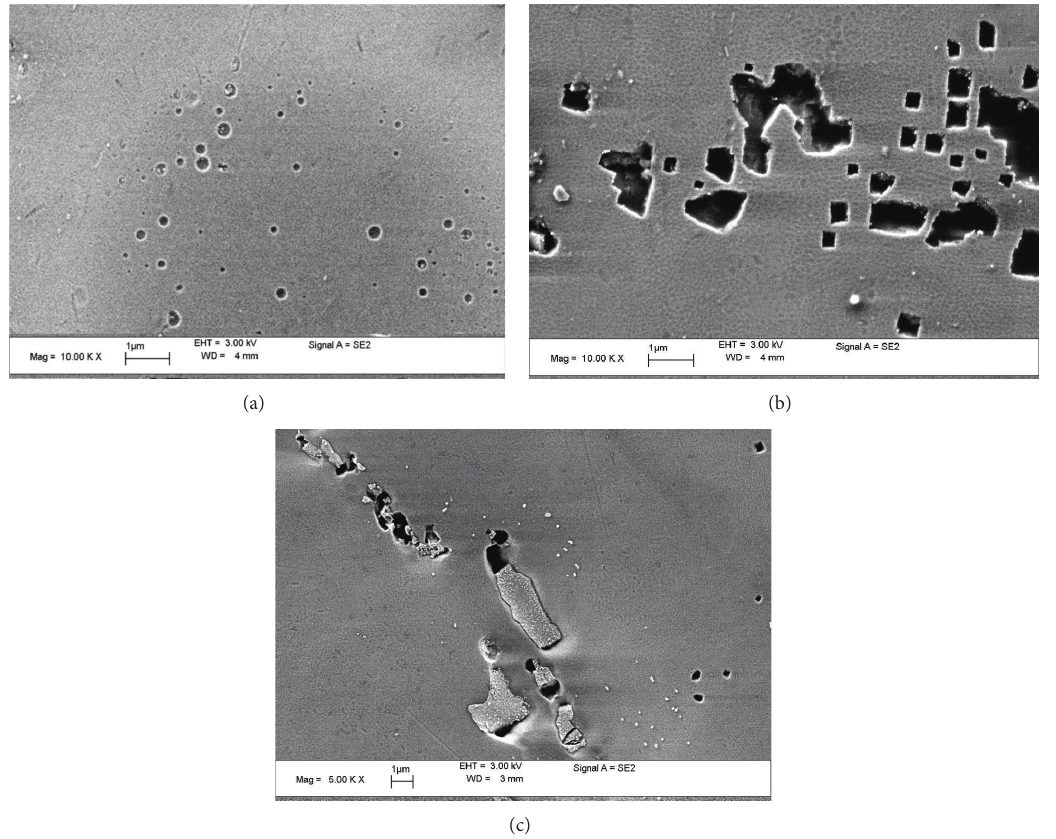
Figure 10: SEM micrographs of the nondeformed ( 𝑁 = 0 ) (a) and ECAP’ed ( 𝑁 = 4 ) (b) samples and the 𝛼 -phase particles which are the pit initiation sites